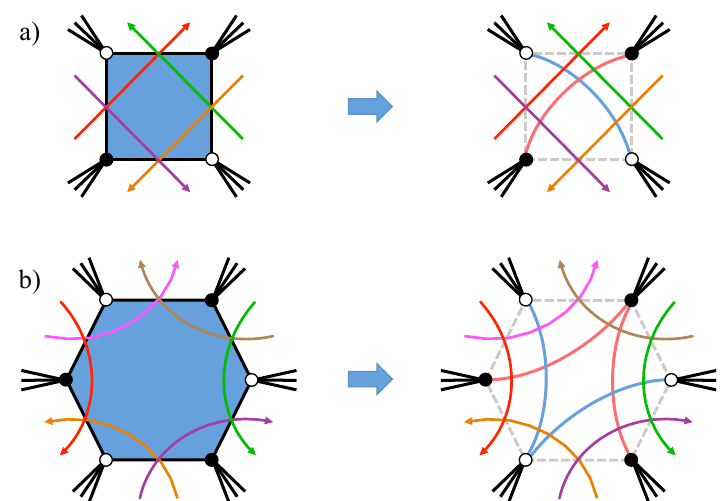
Figure 6. Structure of zig-zag paths around faces in a dimer, and in its backreacted version. Zig-zag paths maintain their structure, in agreement with the fact that punctures in the mirror Riemann surface are unchanged by the backreaction process.